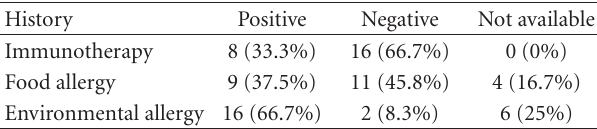
Table 2: Summary of the allergic history of the subjects ( n =